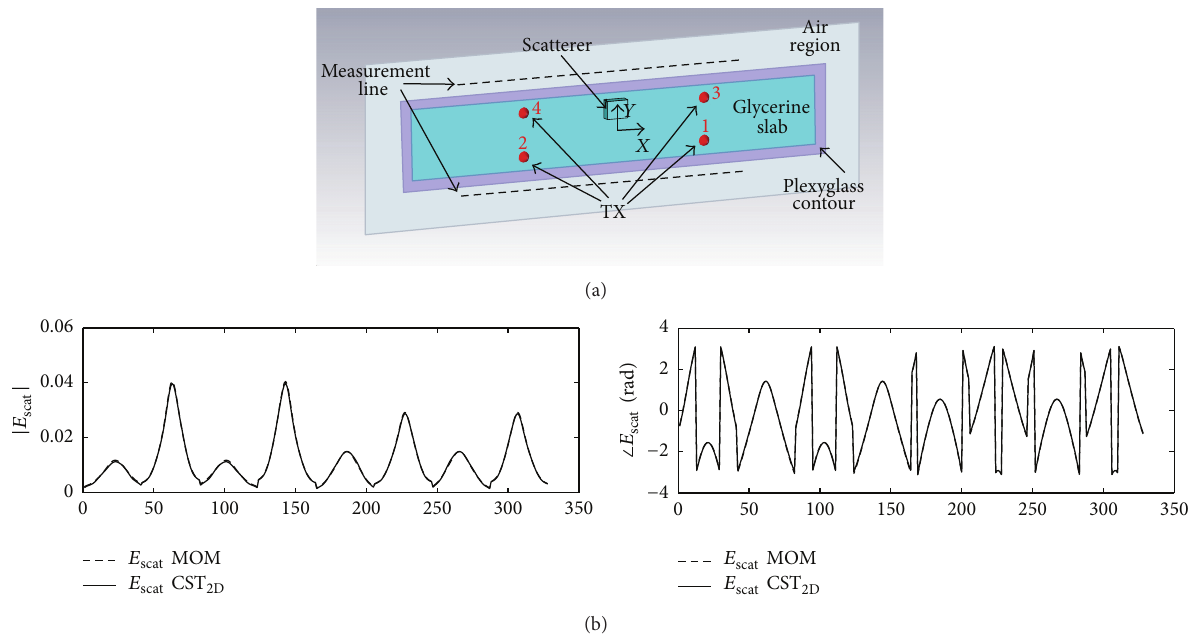
Figure 3: Scattering of a rectangular object using the inhomogeneous GF approach and CST Microwave Studio. (a) CST Simulation model. (b) Plot of the scattered field.